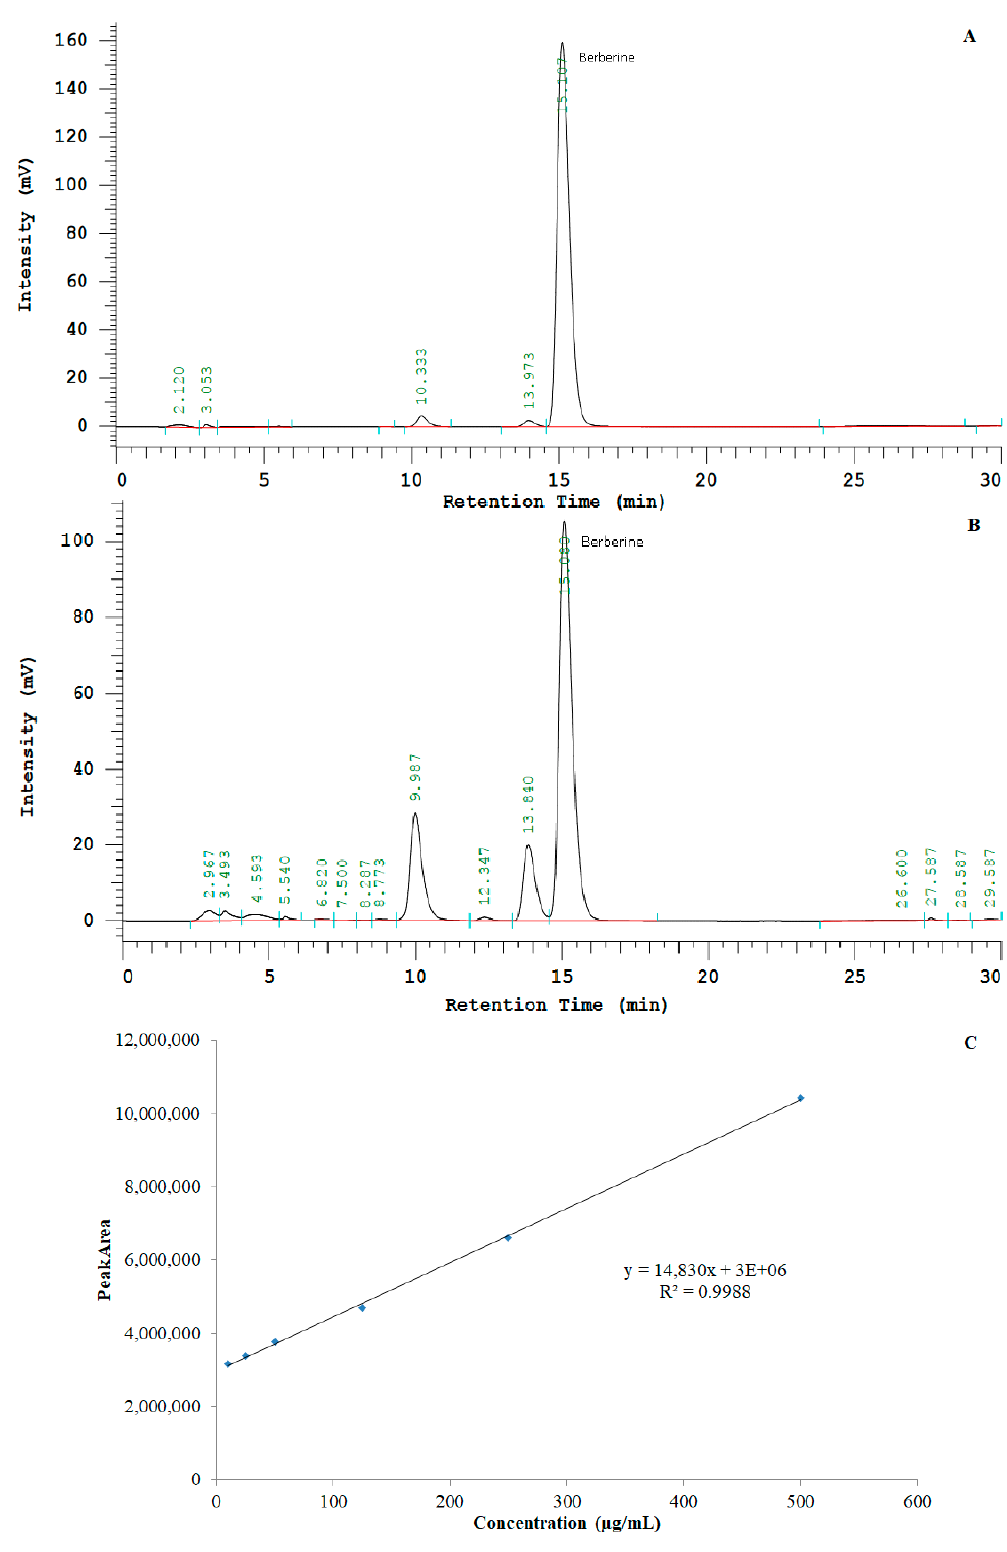
Figure 3. ( A ) HPLC chromatograph of standard berberine chloride at a 125- µ g / mL concentration. ( B ) HPLC chromatograph of Berberis vulgaris root extract ( Bv RE) at a 1-mg / mL concentration. ( C ) Standard curve of berberine chloride, concentration ( µ g / mL) against area under the